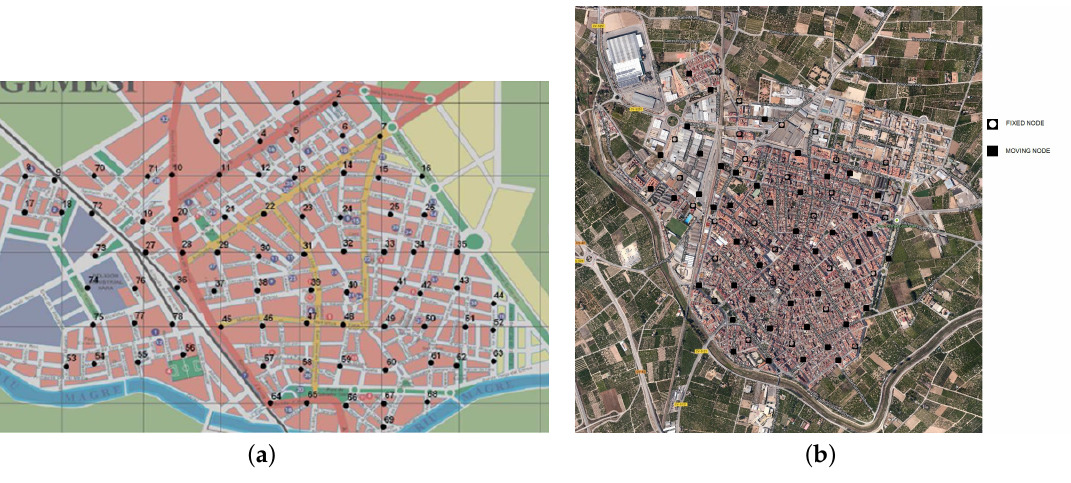
Figure 3. Location of the measurement points for the plan of Algemesí ( a ); fixed nodes and moving nodes ( b